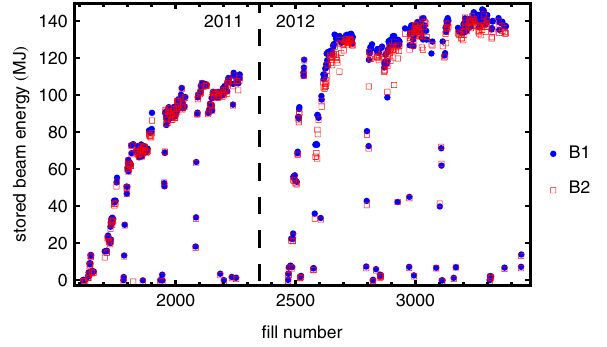
FIG. 1. Stored beam energy, for the two beams called B1 and B2, at the beginning of each LHC physics fill in 2011 and 2012 with proton collisions. The operational energy was 3.5 TeV in 2011 and 4 TeV in 2012. At the beginning of each year, a gradual ramp up in intensity was performed for machine-protection reasons.